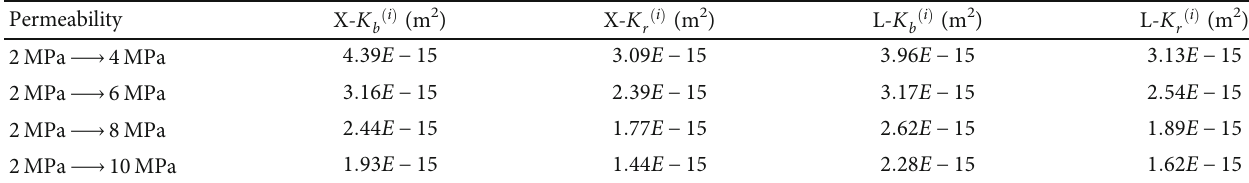
Table 9: The permeability evolution during the loading-unloading process with the axial strain 1.81%. Permeability